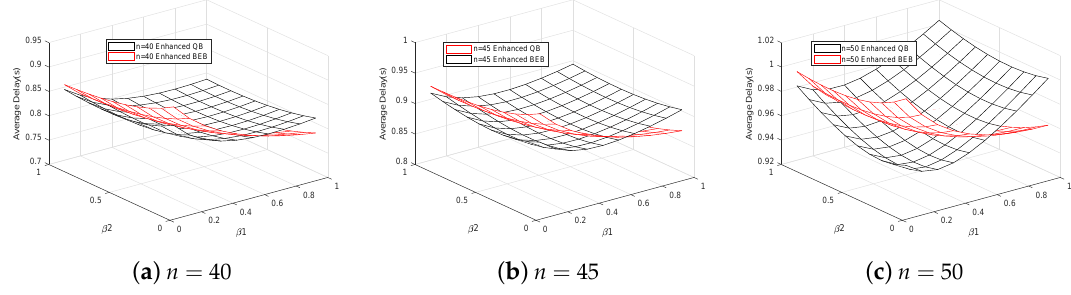
Figure 4. Average total delay with different number of vehicles.